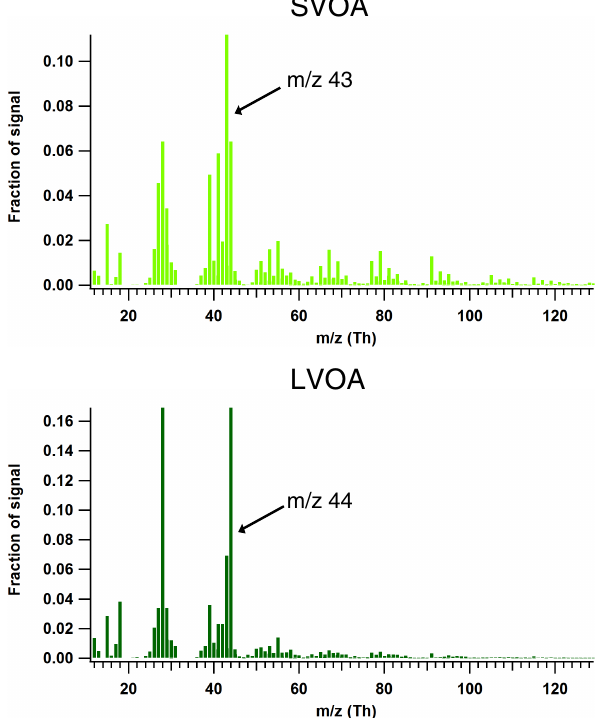
Figure 4. Mass spectrum of SVOA and LVOA obtained from the PMF analysis (two-factor